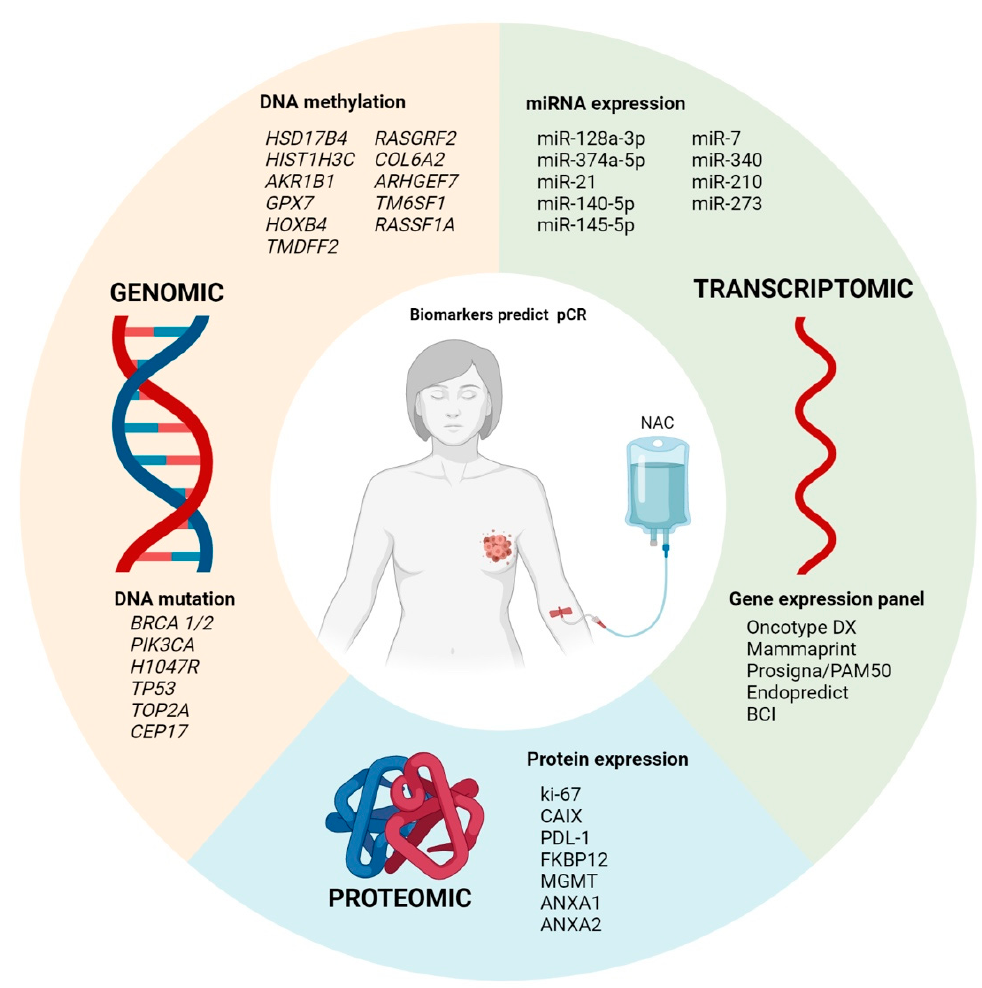
Figure 2. Summary of the main pCR markers at genomic, transcriptomic, and proteomic levels.